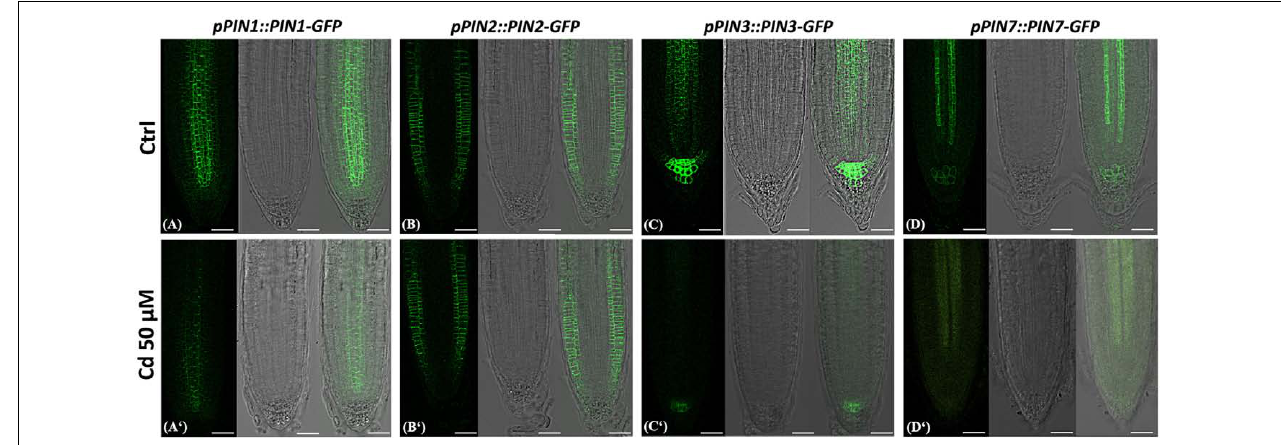
FIGURE 7 | Images of primary root tip in seedlings of A. thaliana pPIN1::PIN1-GFP, pPIN2::PIN2-GFP, pPIN3::PIN3-GFP, pPIN7::PIN7-GFP transgenic lines germinated (A–D) on growth medium as control (Ctrl) and (A ‘ –D ‘ ) on medium added with 50 µ M Cd for 8 DAG. From left to right: confocal laser image; transmission image; merged image. Scale bars 46 µ m.